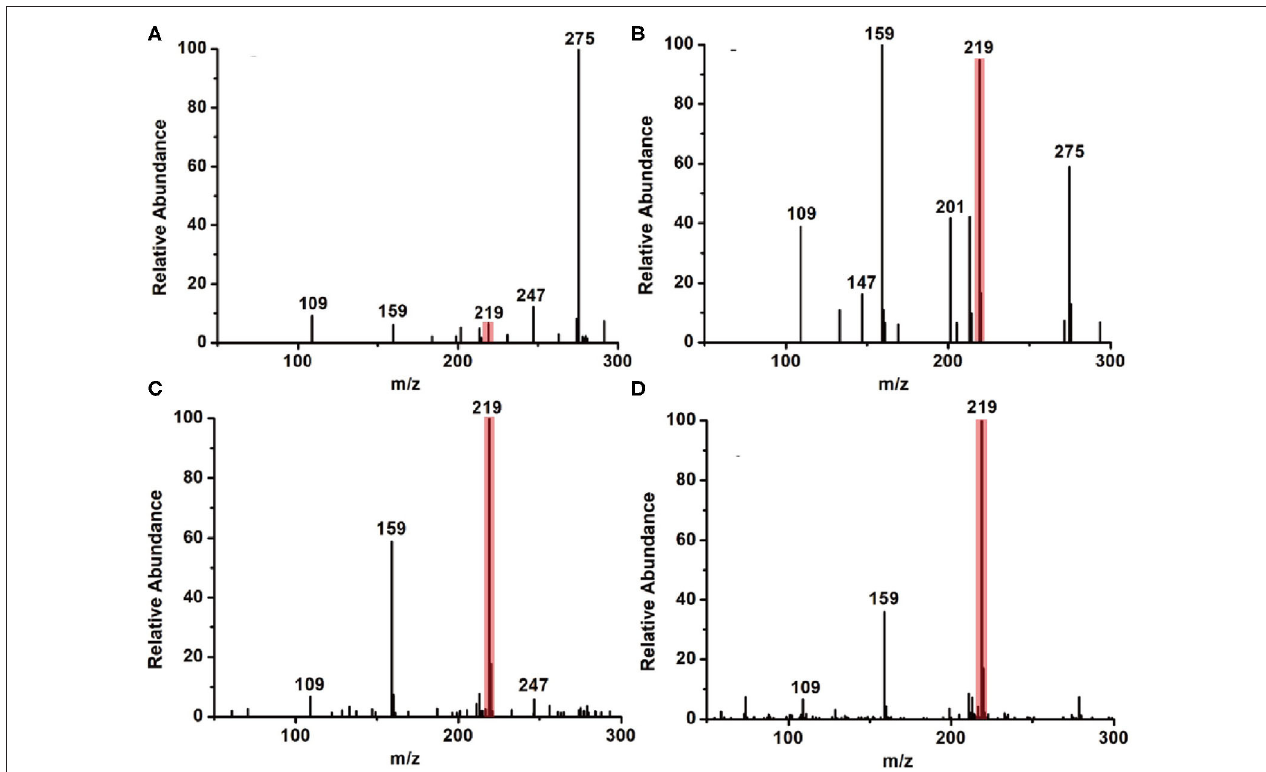
FIGURE 3 | The MS results of the model reaction under (A) methanol and (B) methanol–water solution (v: v = 1: 1) environment without N 2 . (C) The MS results of the model reaction under methanol–water solution (v: v = 1: 1) conditions without N 2 . (D) The MS results of the model reaction under methanol–water solution (v: v = 1: 1) conditions with N 2 (40